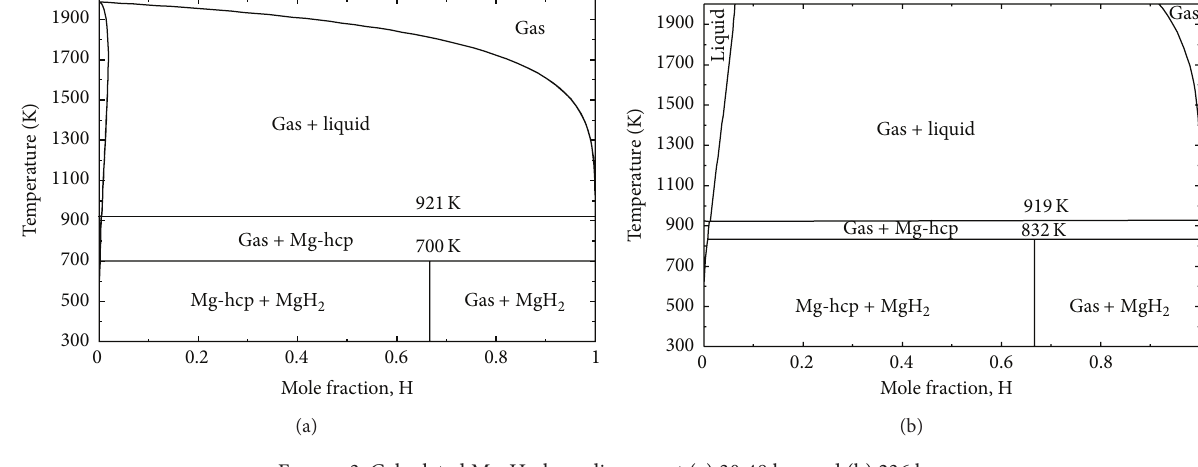
Figure 3: Calculated Mg-H phase diagram at (a) 30.48 bar and (b) 236 bar.